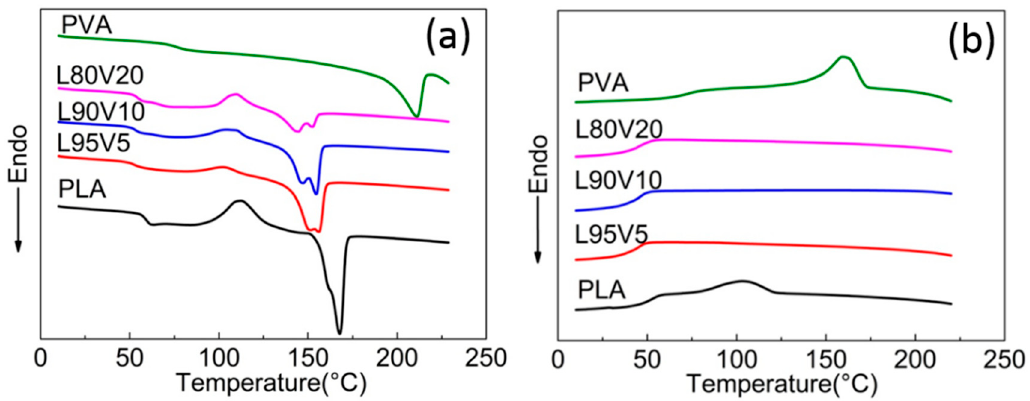
Figure 3. The second heating ( a ) and cooling ( b ) DSC curves of the PLA fiber membrane.